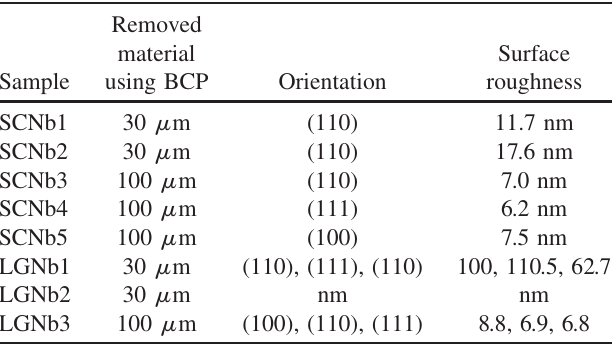
TABLE I. Overview of the investigated single crystal and large grain Nb samples. (nm used for not measured samples).